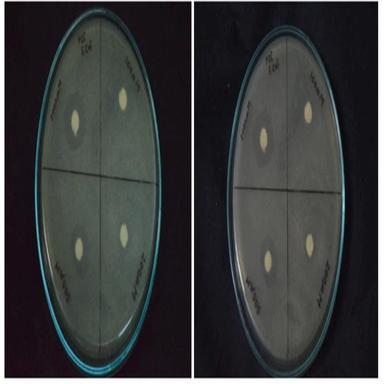
Zone of inhibition against E. Coli by (a) Standard streptomycin (b) DMPI and (c) IC-1(Inclusion complex of HP-β-CyD and DMPI) (d) E. coli standard.